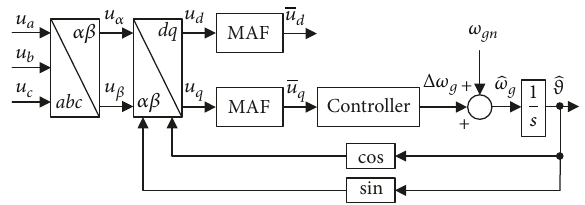
Figure 2: PLL with the nonadaptive MAF and a controller.